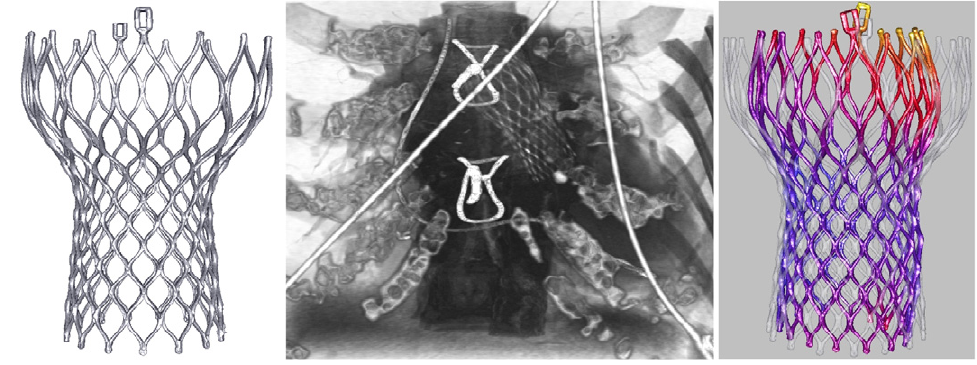
Figure. 9 Deformation analysis of T-AVI stent: undeformed stent model (left), postoperative CT (center), deformed stent model (right).